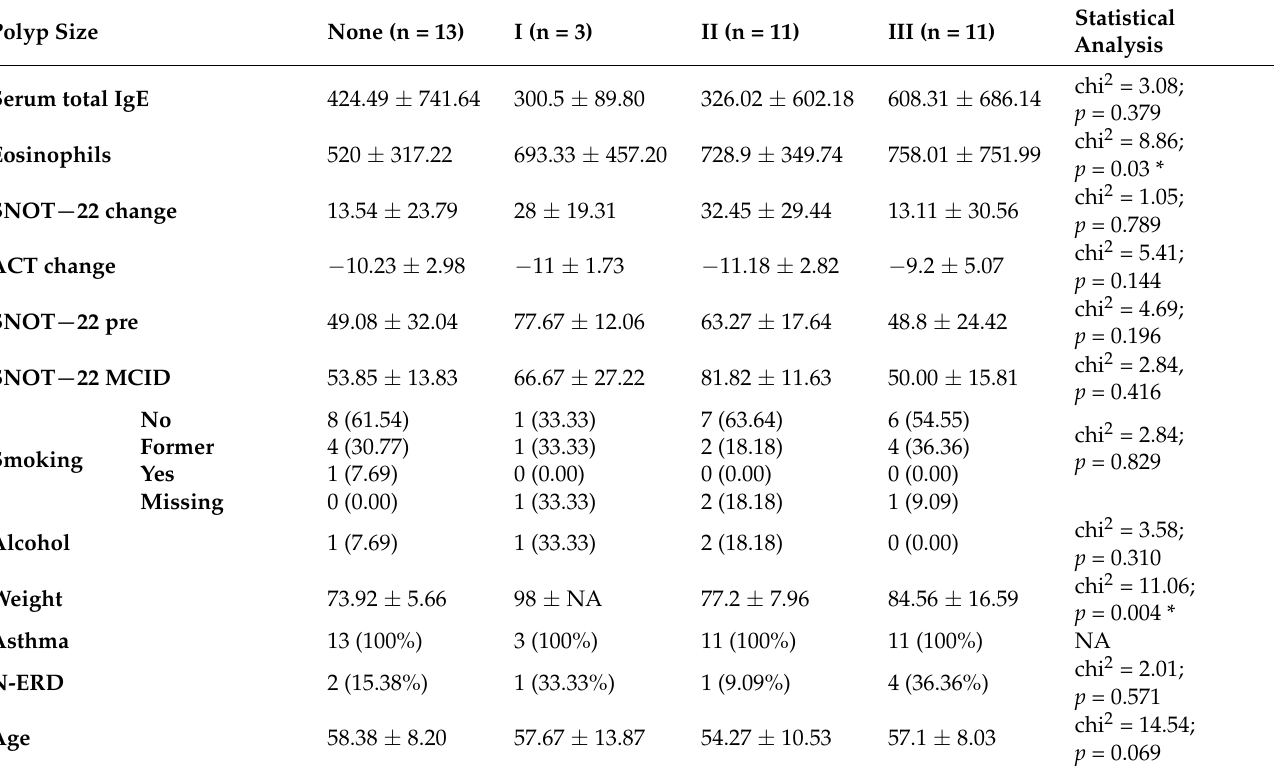
Table 3. Relationship between the size of the polyps with different variables. MCID (minimal clinically important difference). NA (not applicable) Bold and asterisk if the difference is statistically significant ( p <